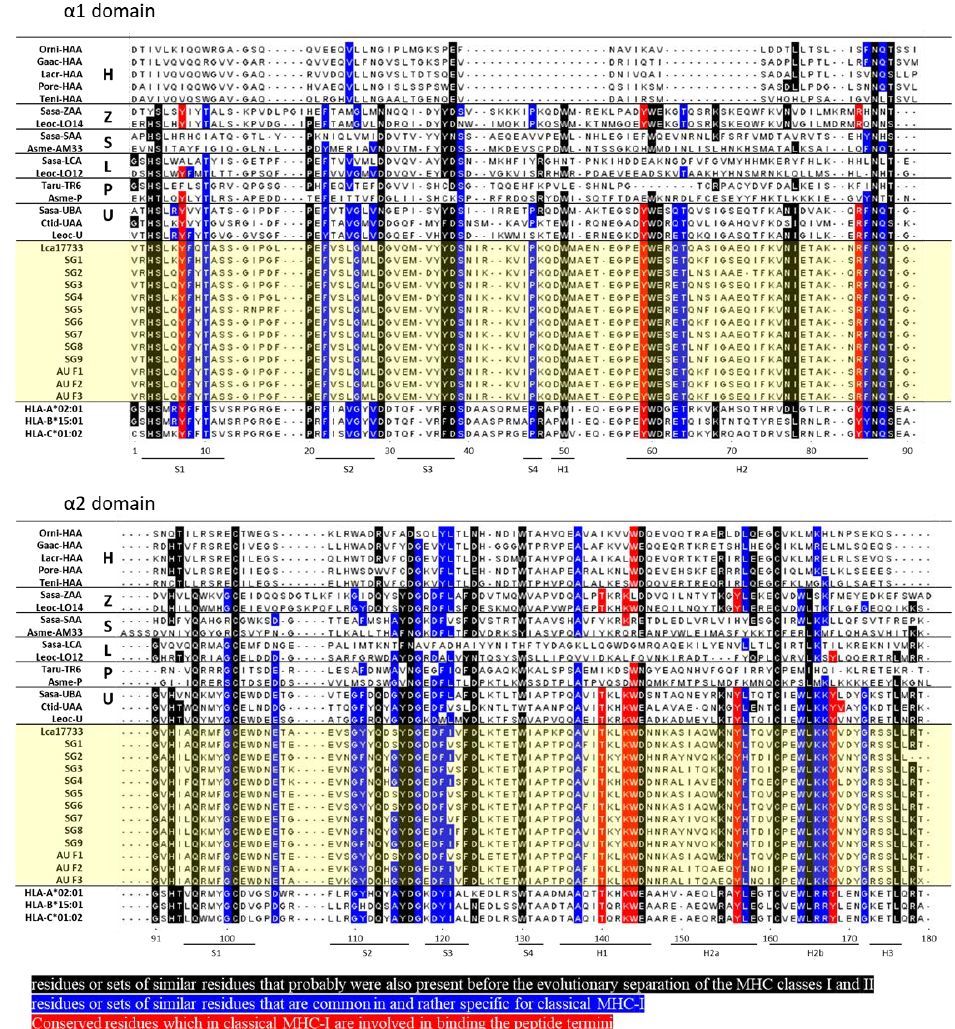
Figure 1. Alignment of Asian seabass MHC-I α 1 and α 2 amino acid sequences with other represen- tative MHC-I sequences. Multiple sequence alignment of Asian amino acid sequences with other representative fish MHC-I and human HLA sequences. Black indicates similar residues that were probably found before the molecular evolution of MHC classes I and II, blue indicates similar residues that are common in classical MHC-I, and red indicates conserved binding residues in classical MHC-I. The sequences are divided into α 1 and α 2 regions, which correspond to exon 2 and exon 3, respectively. The residue positions indicated below the alignment are based on the HLA-A2 protein. Structural indications S denotes the β -strand and H denotes the helix based on the pHLA-A2 structure (PDB